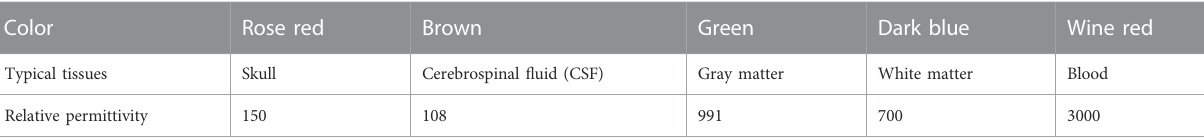
TABLE 1 Relative permittivity of each part in the ICH model (frequency 1 MHz) [11]. Color Rose red Brown Green Dark blue Wine red Typical tissues Skull Cerebrospinal fl uid (CSF) Gray matter White matter Blood Relative permittivity 150 108 991 700